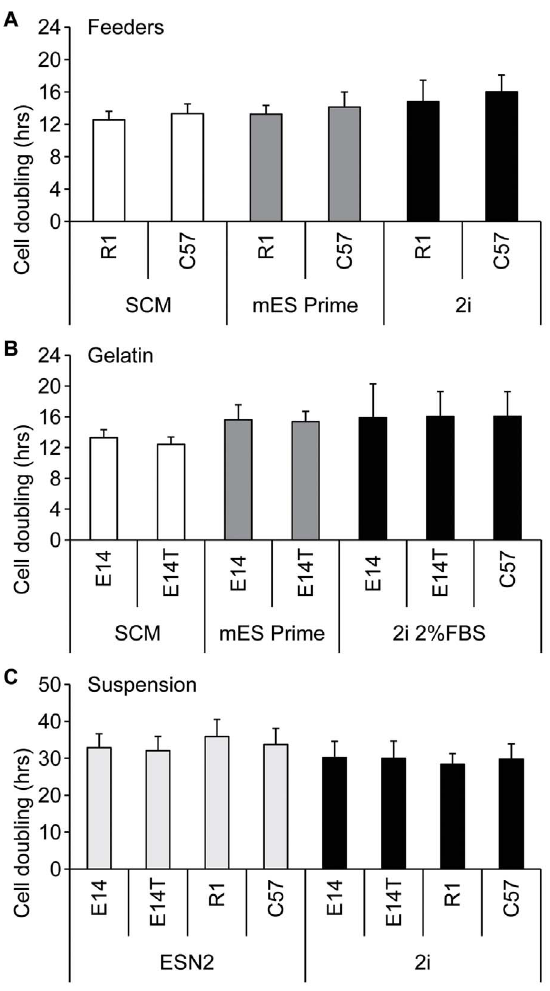
Figure 3. Proliferation rates of mouse ES cells cultured using different protocols. Cell doubling time assessment of mES cells grown on feeders (A) in SCM, mES Prime Kit and 2i media; on gelatin (B) in SCM, mES Prime Kit and 2i media supplemented with 2% FBS; or in suspension (C) in 2i and ESN2 media. Results are means 6 sd for 5 consecutive passages (n=3).